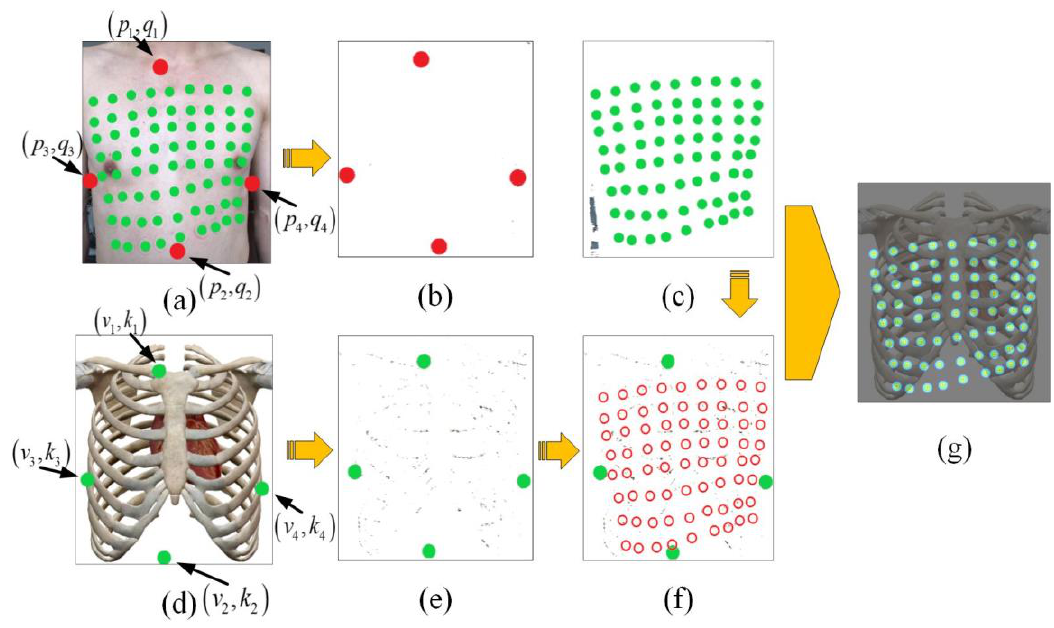
Figure 7. Diagram of channel location. ( a ) Image of marked chest surface; ( b ) sensor registration markers extracted from the chest image; ( c ) sensor markers extracted from the chest image; ( d ) image of human skeleton with the skeleton registration markers; ( e ) skeleton registration markers extracted from the human skeleton image; ( f ) sensor arrangement after registration between sensor registration markers and skeleton registration markers; ( g ) image of the sensor arrangement in the skeleton image after registration.